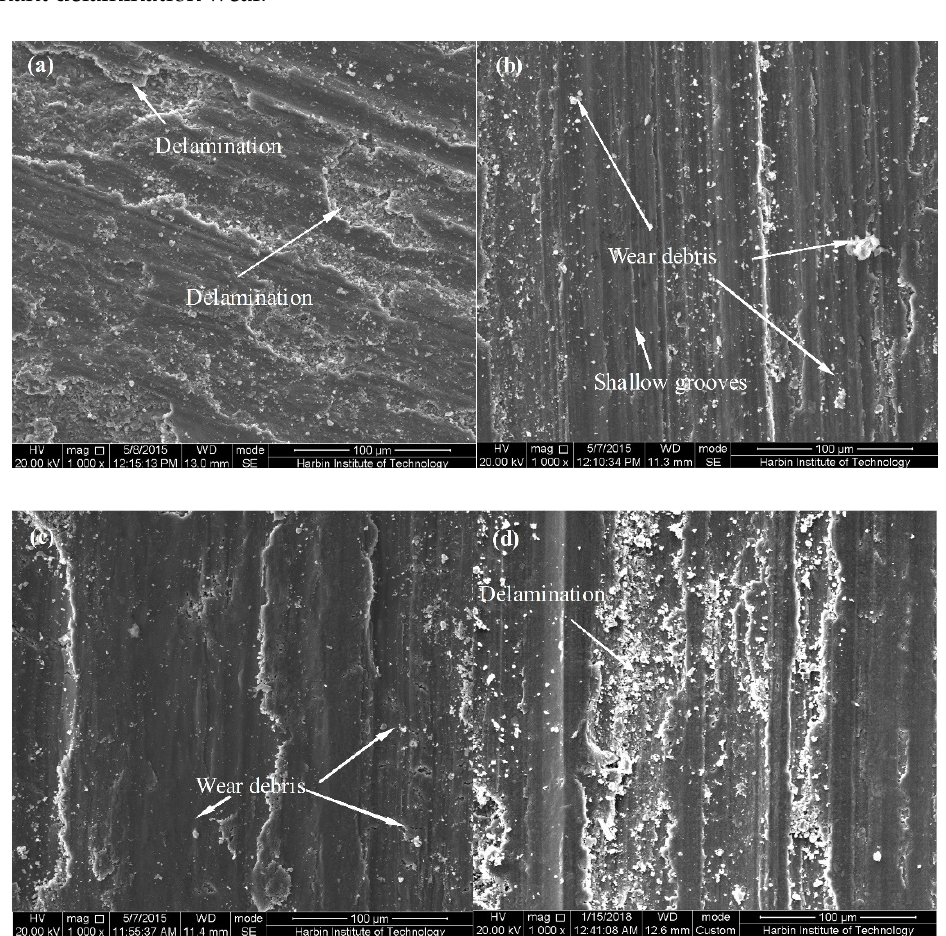
Figure 8. Worn surface morphology of the rheoformed composite parts at different applied load: ( a ) 20 N, ( b ) 30 N, ( c ) 40 N and ( d ) 50 N.